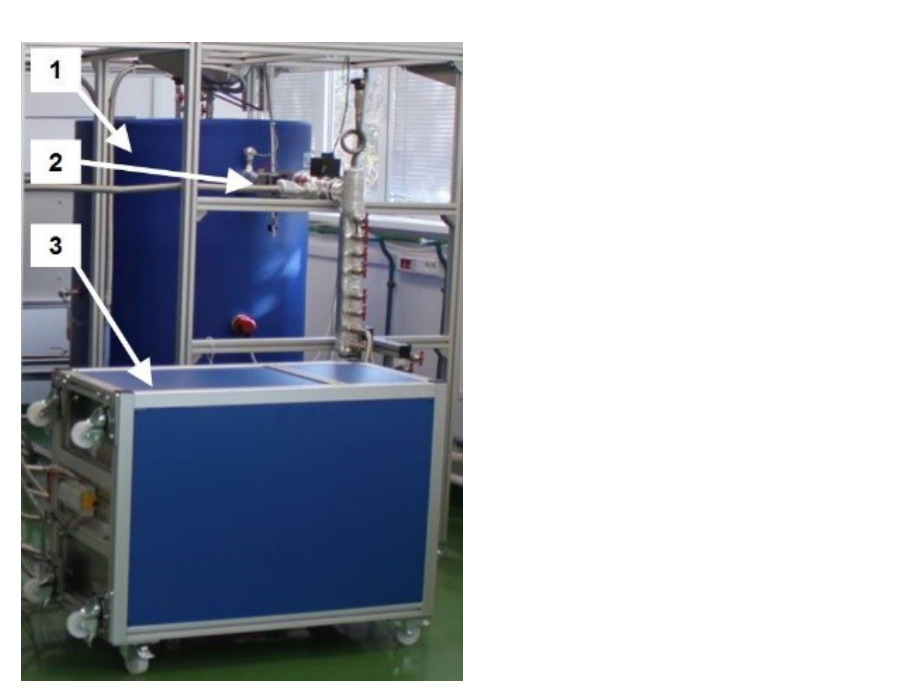
Figure 6. View of the experimental stand with the MTEG: 1—waste heat source with adjustable parameters, 2—connections with a pump, 3—MTEG in a thermally insulated housing. Table 1. Selected parameters of the thermoelectric modules MTEG, own elaboration based on